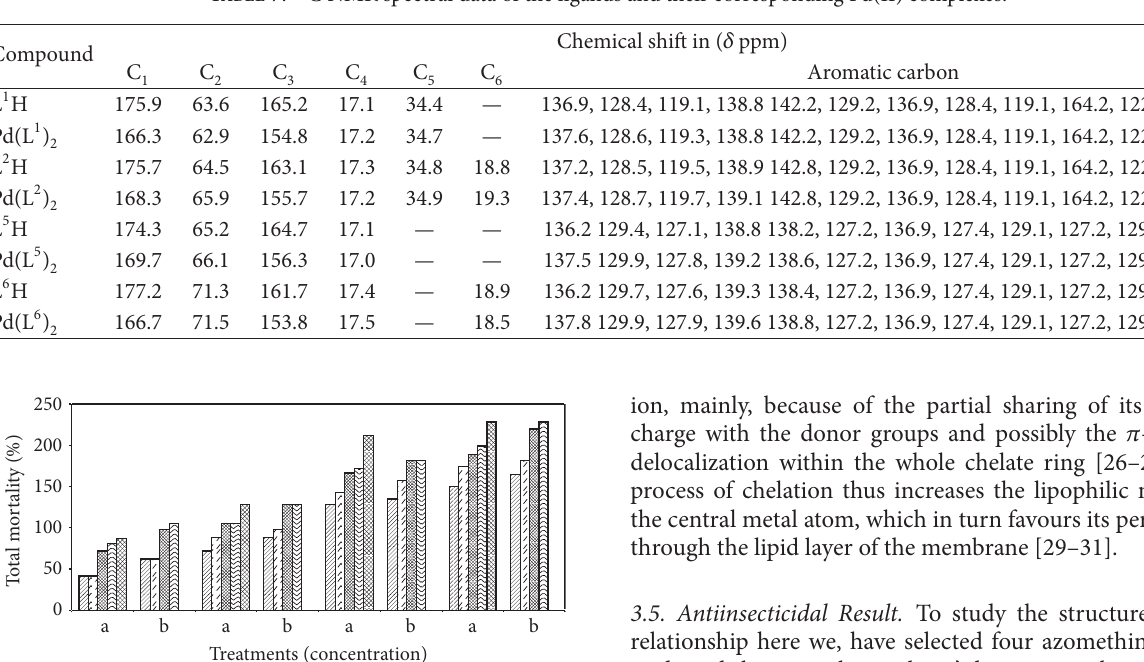
T 7: 13 C NMR spectral data of the ligands and their corresponding Pd(II) complexes.